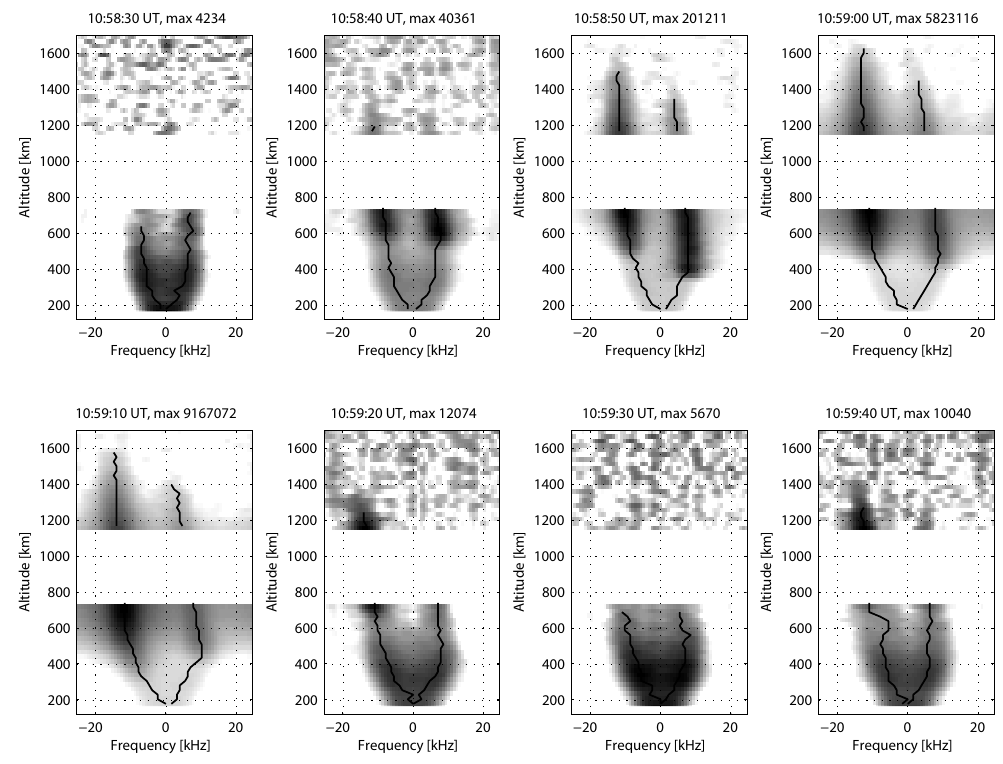
Fig. 3. Fig. 3. NEIALs observed with the ESR 32m antenna between 10:58:30 and 10:59:30 UT on 28 July 2000. Power spectra from channel 3, altitude 200–850km and 1200–1650km (background) are plotted with a gray scale. A format of the plots is same as Fig. 2. The spectra are multiplied by the range squared and normalized to the value given at the